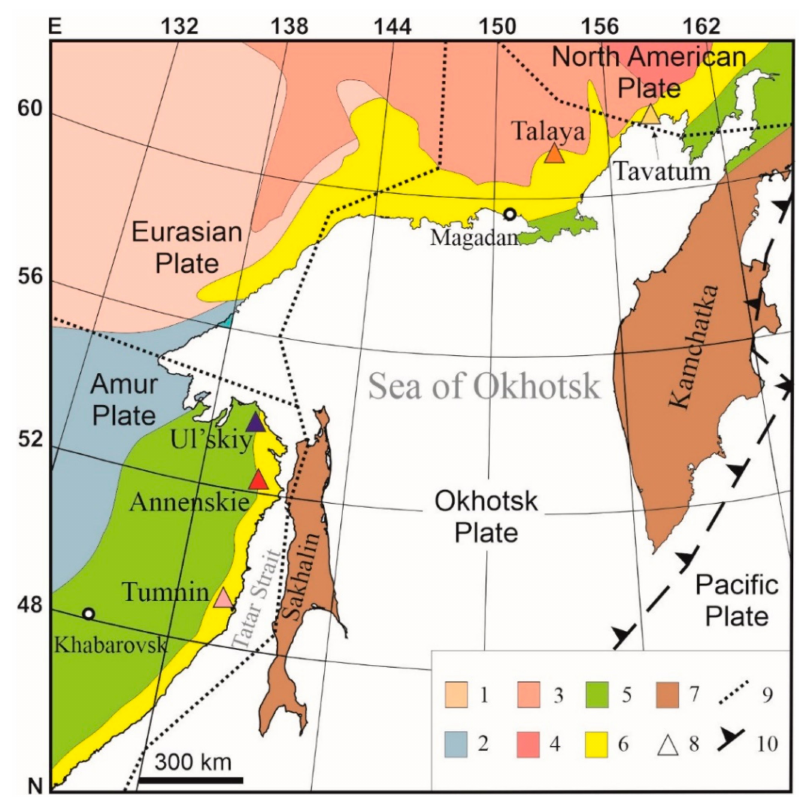
Figure 1. Tectonic sketch map of the studied area with the sampling points. Modified after